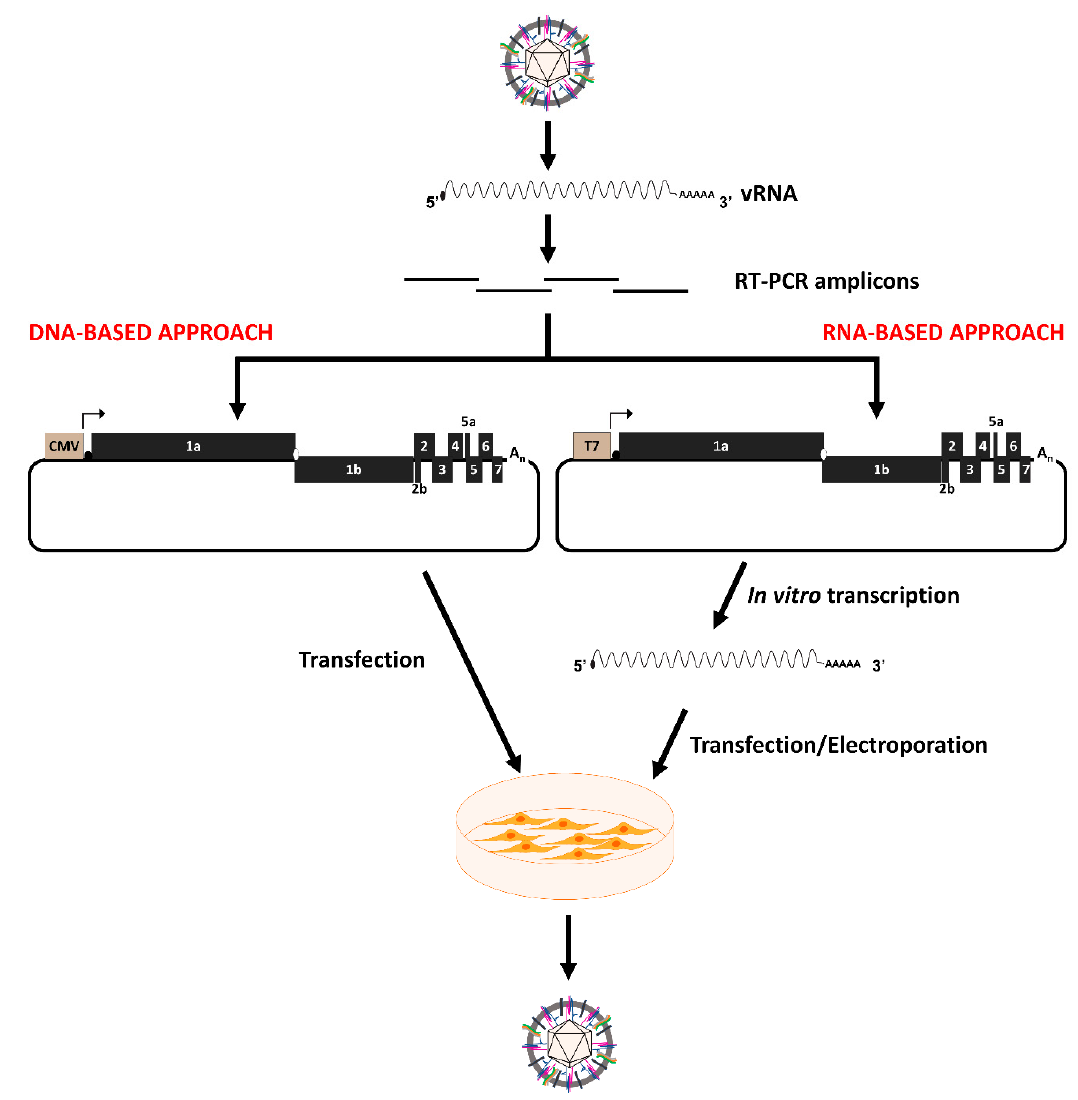
Figure 1. Overview of the approaches to generate an infectious cDNA clone for PRRSV. The PRRSV genomic RNA is isolated and reverse transcribed (RT) to produce complementary DNA (cDNA). Overlapping cDNA amplicons encompassing the full-length viral genome are amplified by reverse transcribed PCR (RT-PCR) and assembled into a bacterial plasmid. For the DNA-based transfection approach, the cDNA genome is cloned downstream of a polymerase II (such as CMV) promoter. The resulting plasmid can be directly transfected into a permissive cell line to rescue the progeny virus. For the RNA-based transfection approach, the cDNA genome is cloned downstream of a bacteriophage (such as T7) promoter. Full-length viral RNA transcript is produced through the use of an in vitro transcription reaction. The viral RNA transcript is transfected or electroporated into a permissive cell line to rescue the infectious virus.